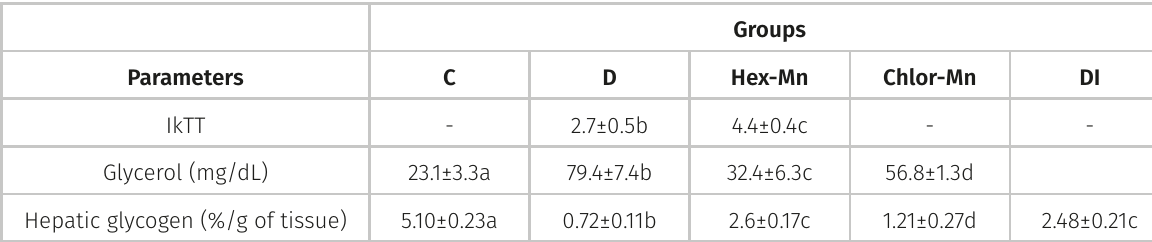
Table IV. Effect of Hex-Mn and Chlor-Mn fractions on IkTT, serum glycerol and hepatic glycogen in control and diabetic treated for 21